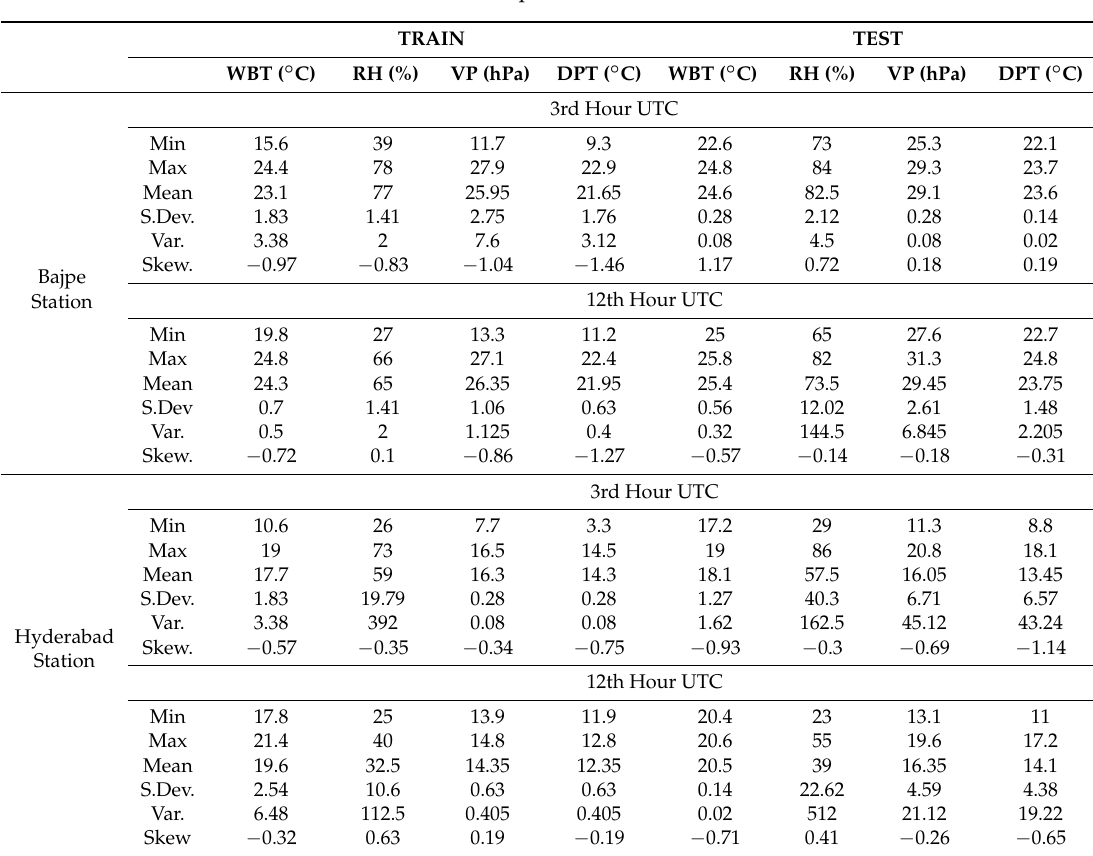
Table 2. Statistical parameters of the